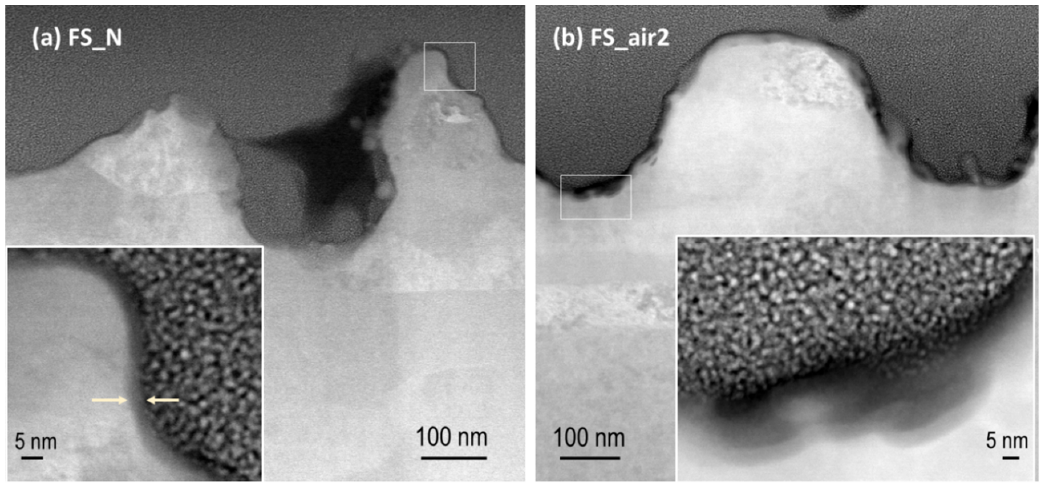
Figure 3. HAADF-STEM images of a cross-section of sample ( a ) FS_N and ( b ) FS_air2, near the surface. The insets show the areas highlighted by a white rectangle in the corresponding main images, with higher magnification.